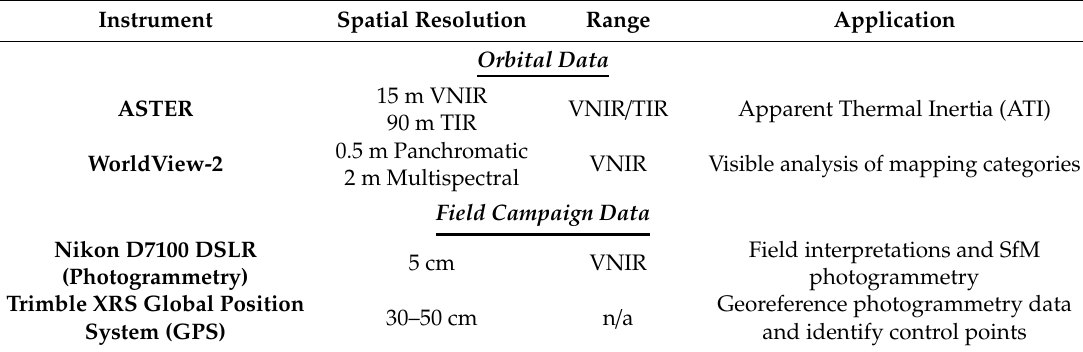
Table 1. Description of the datasets used with instrument spatial resolution, spectral range, and scientific applications. Instrument Spatial Resolution Range Application Orbital Data 15 m VNIR ASTER VNIR / TIR Apparent Thermal Inertia (ATI) 90 m TIR 0.5 m Panchromatic WorldView-2 VNIR Visible analysis of mapping categories 2 m Multispectral Field Campaign Data Nikon D7100 DSLR Field interpretations and SfM 5 cm VNIR (Photogrammetry) photogrammetry Trimble XRS Global Position Georeference photogrammetry data 30–50 cm n / a System (GPS) and identify control